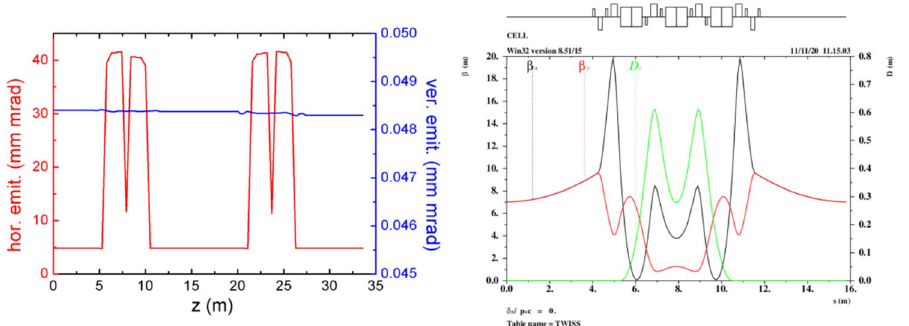
Figure 3. Emittance evolution (left) and the layout and optical function